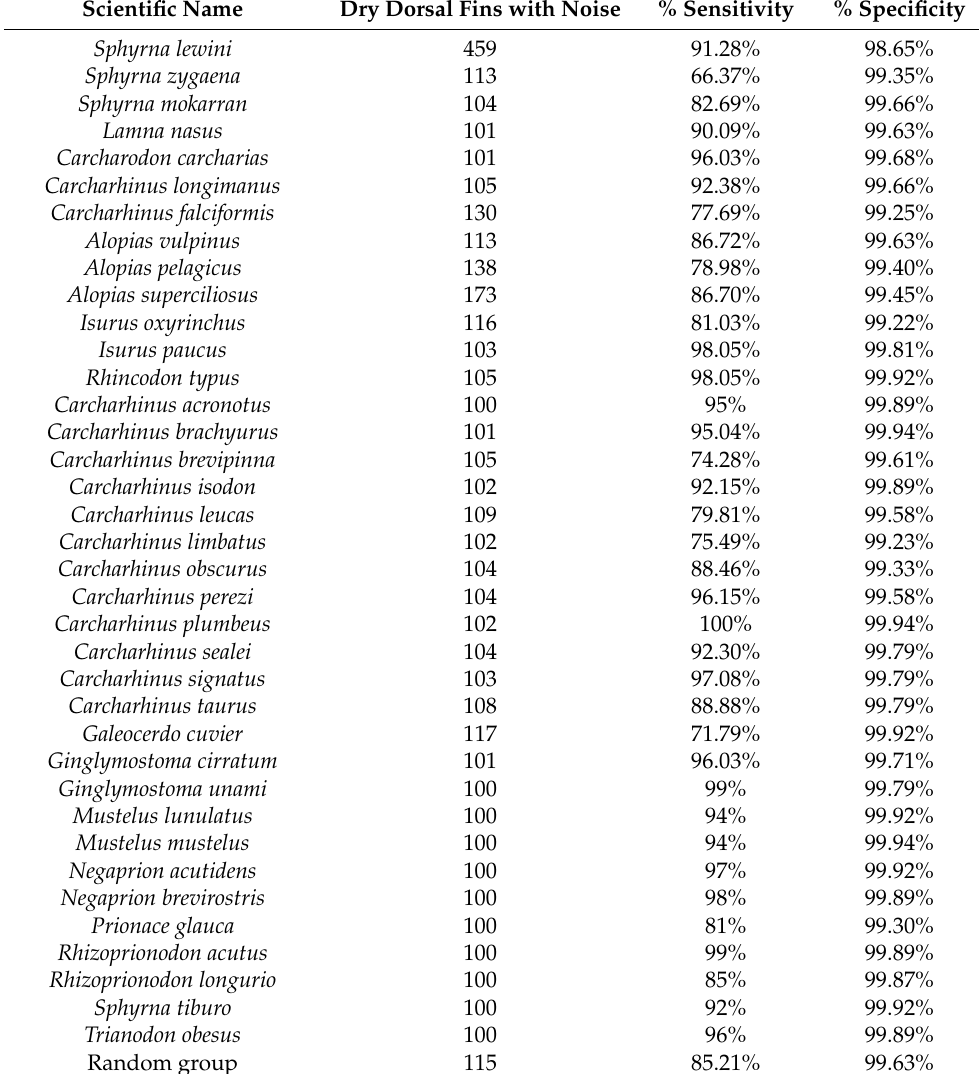
Table 7. Sensitivity and specificity percentage of each dry dorsal fin shark species using the neural network with 89% efficiency. This table represents the database of dry shark fins with noise in the background of the